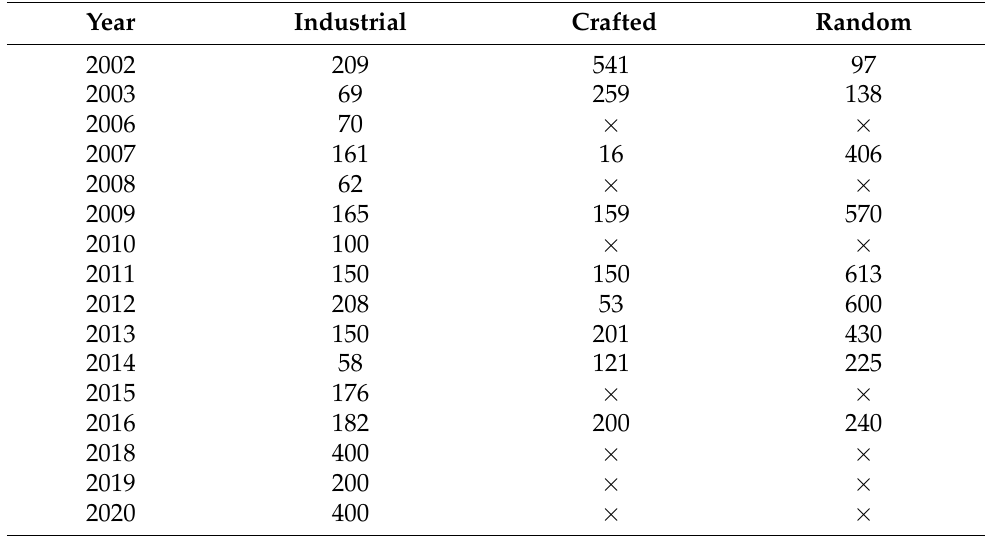
Table A1. Number of instances included in experiments drawn from 2002–2020 SAT benchmarks. The symbol means that no instances were submitted under the corresponding ×